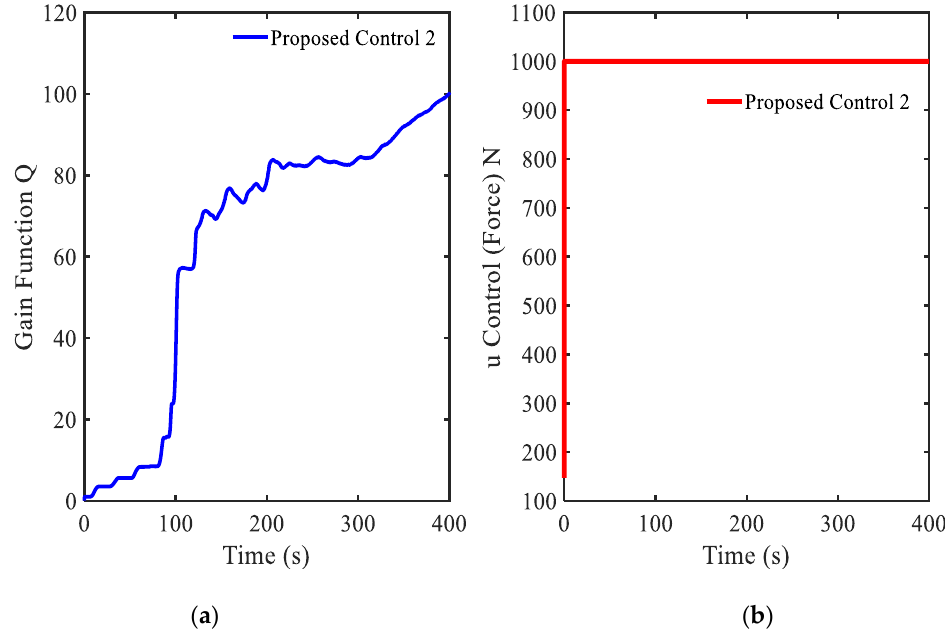
Figure 14. Control results under random step wave road excitation: ( a ) gain function Q ∆ L ( t ) , ( b ) main control u ∗ ( t ) .